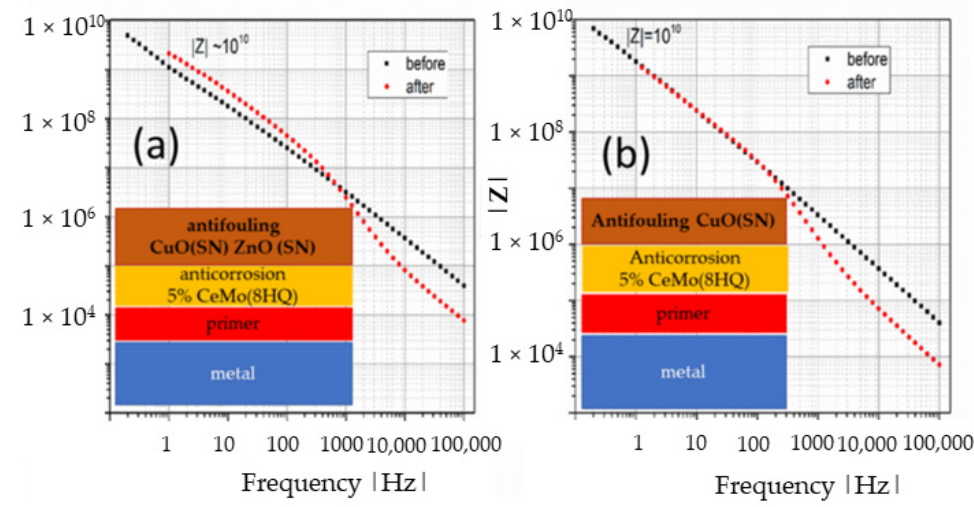
Figure 5. FRA of paints (( a ) nanocontainer technology and ( b ) commercial paint) before and after immersing the samples in seawater for three paints.